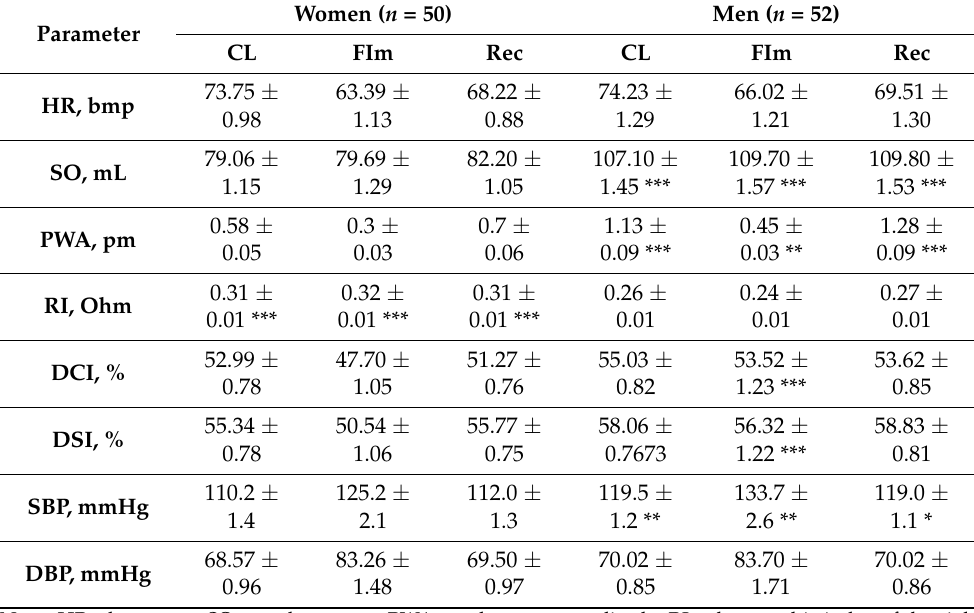
Table 3. Sex-related differences in the blood flow parameters before, during, and after diving reflex imitation. Women ( n = 50) Men ( n = 52) Parameter CL FIm Rec CL HR, bmp